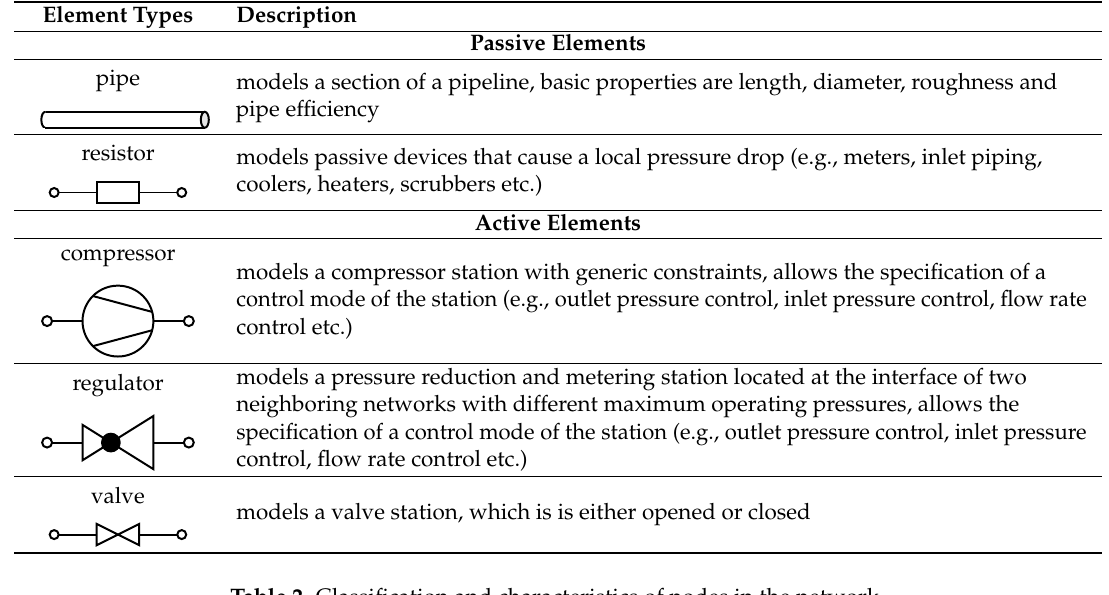
Table 2. Classification and characteristics of nodes in the